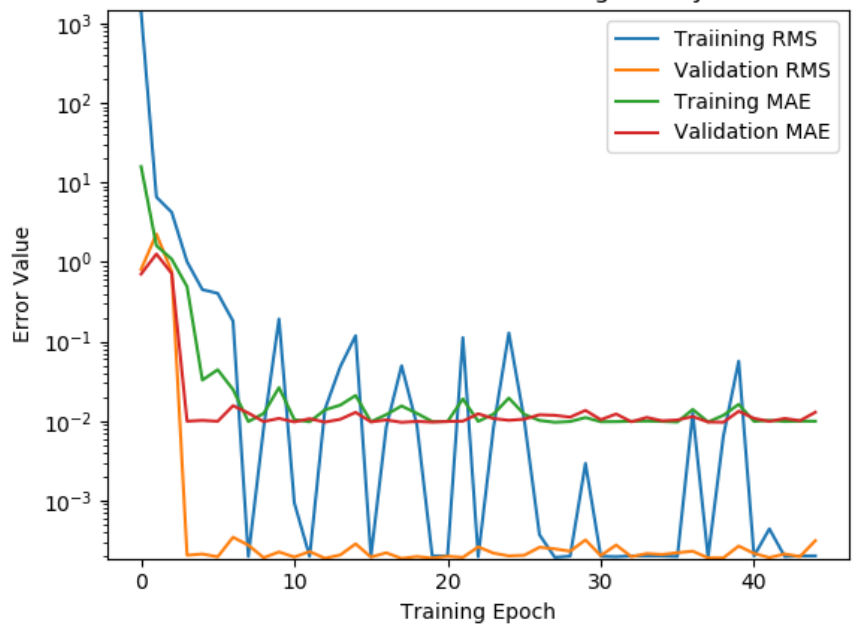
Figure 1. Training history of the neural network for predicting assembly Kinf